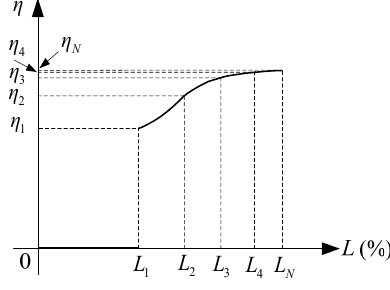
Figure 2. Relation between η and loading level.